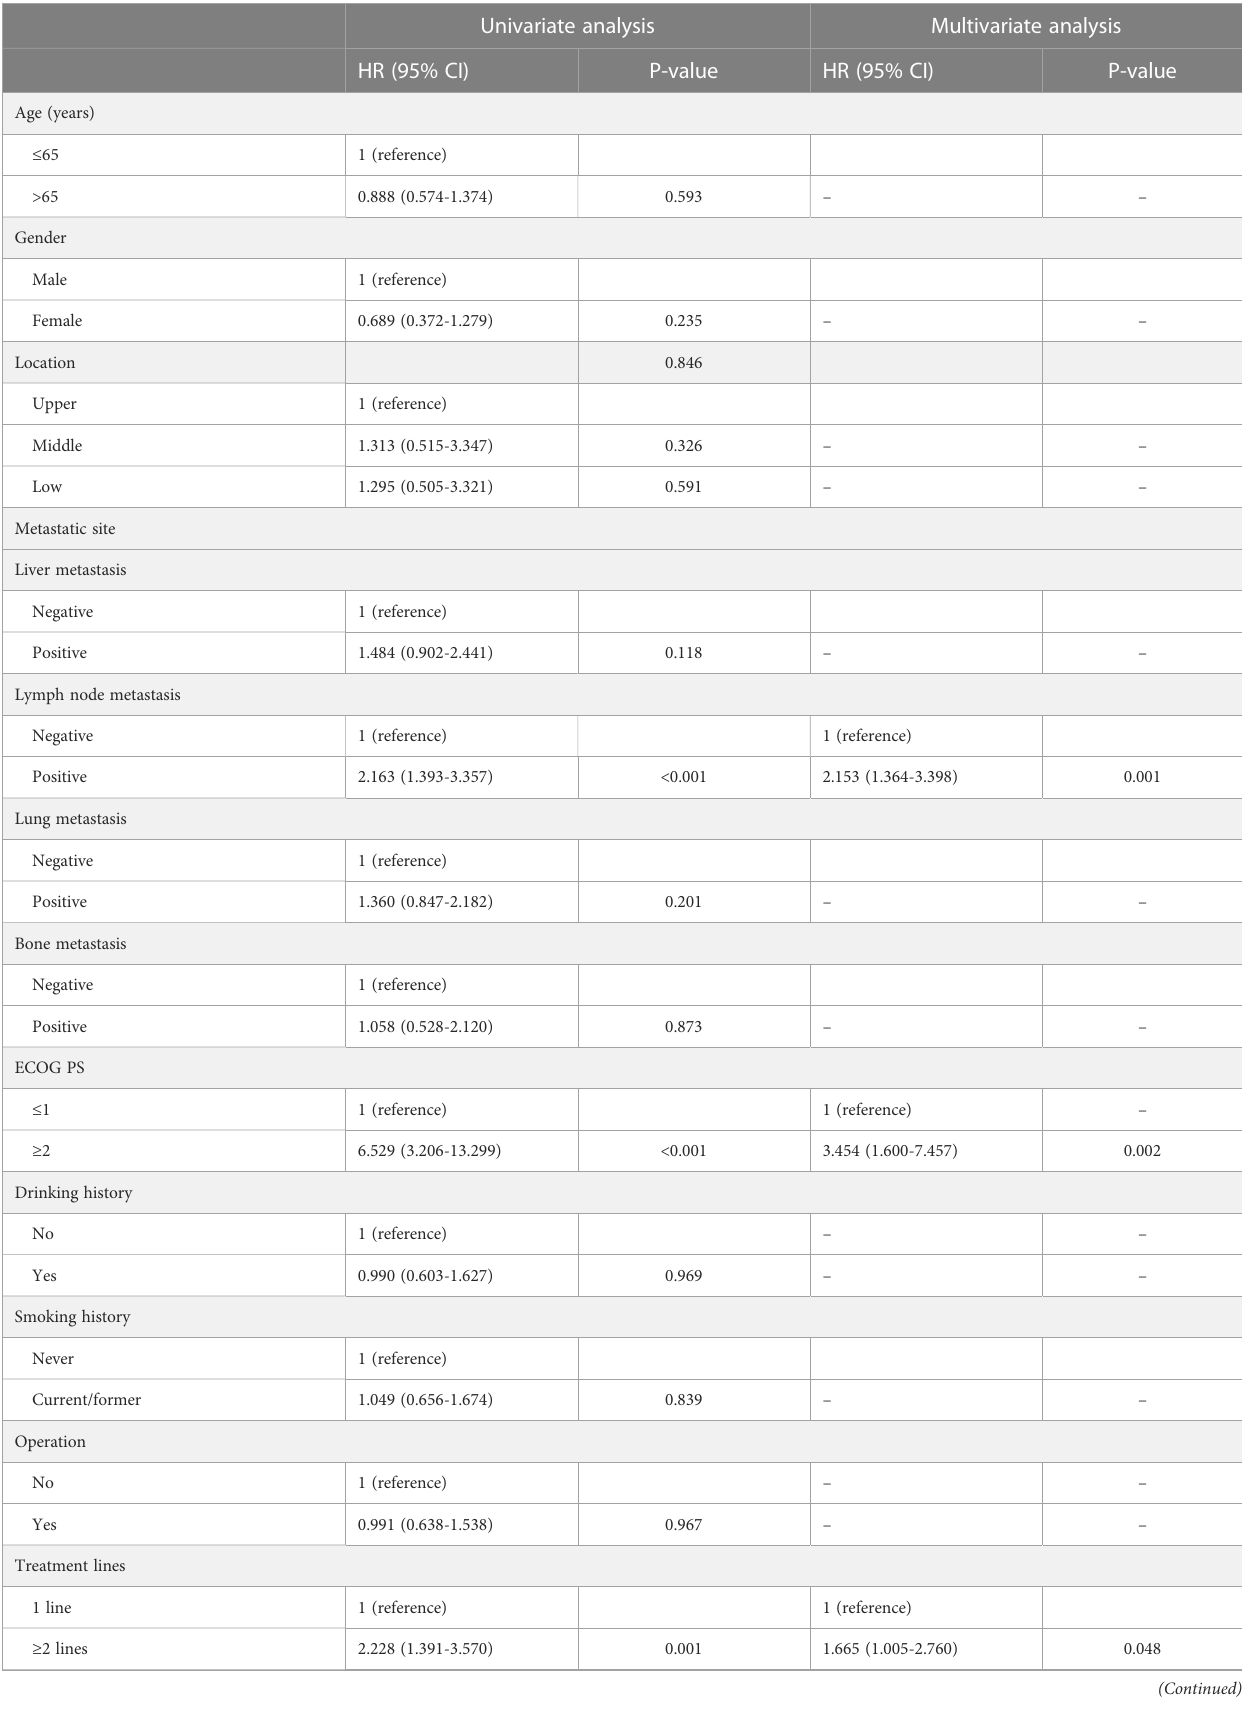
TABLE 3 Univariate and multivariate analysis of OS in advanced or metastatic ESCC patients receiving anti-PD-1